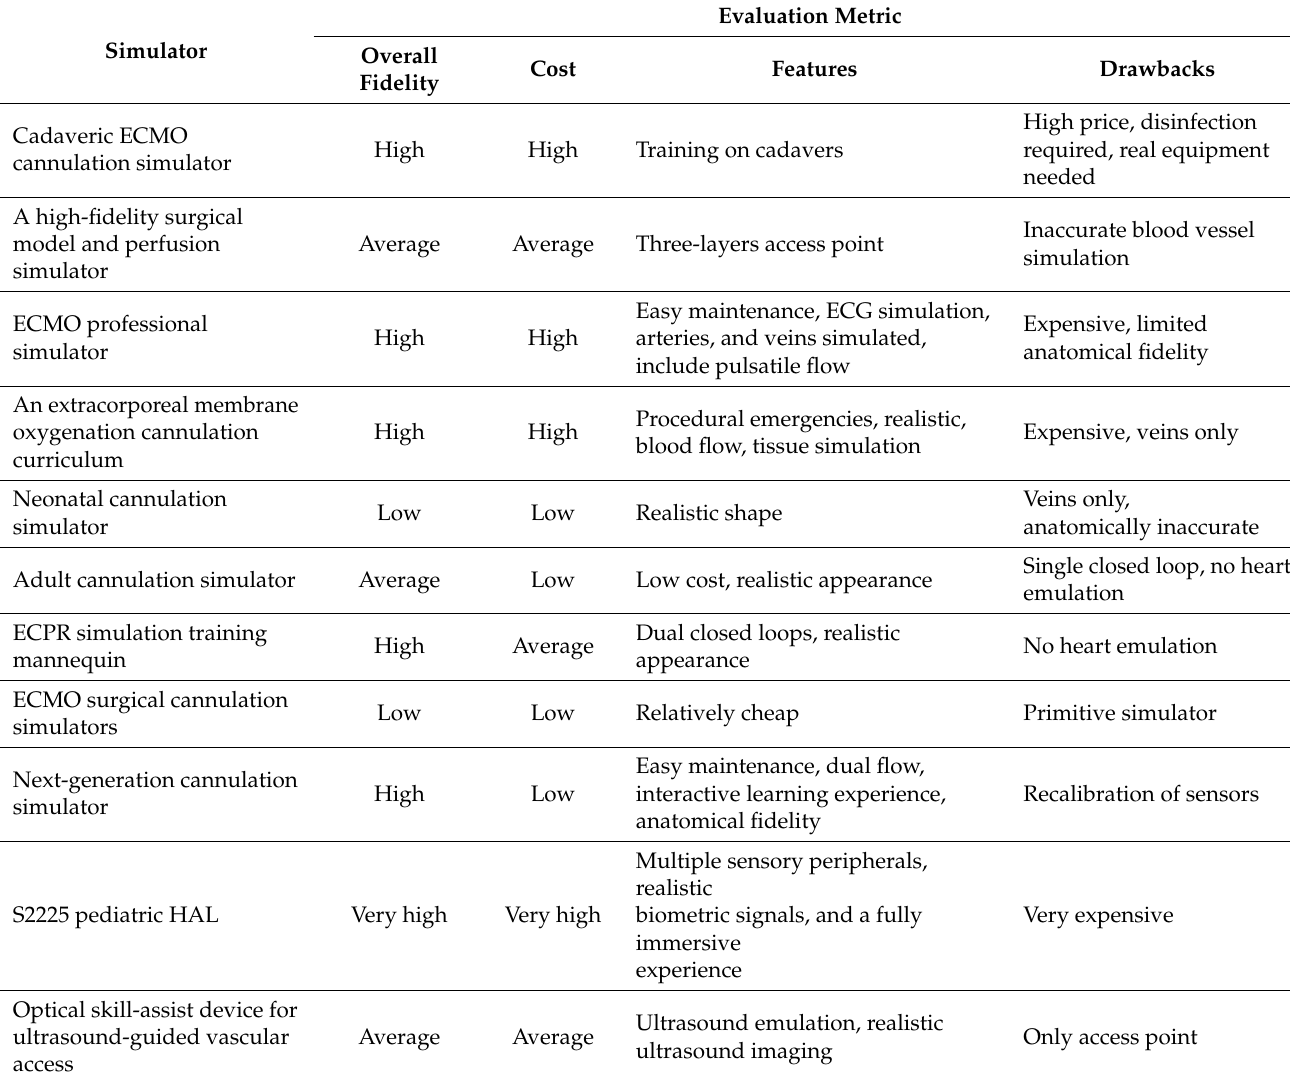
Table 1. Summary of existing HSCS systems and auxiliary